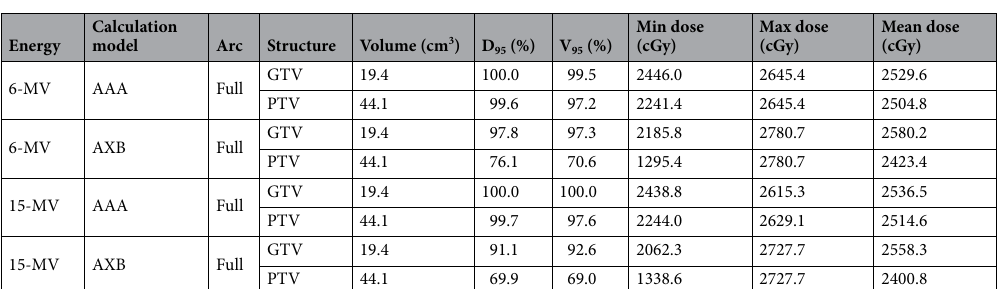
Table 2. Dose statistics of targets (GTV and PTV) from full arcs volumetric modulated arc therapy (VMAT) plans. GTV gross tumor volume, PTV planning target volume.